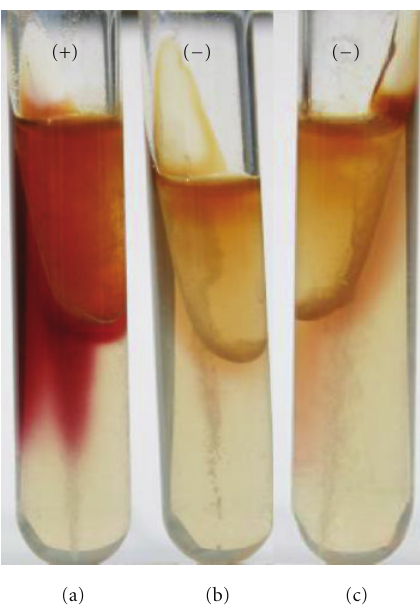
Figure 5: Pyrazinamidase test. A brownish pink color indicates formation of pyrazinic acid and is a positive pyrazinamidase reaction. Y. enterocolitica serotype O:5/biotype 1A (a) is positive and Y. enterocolitica serotype O:3/biotype 3 variant VP − (b) and Y. pseudotuberculosis serotype 4b (c) are negative